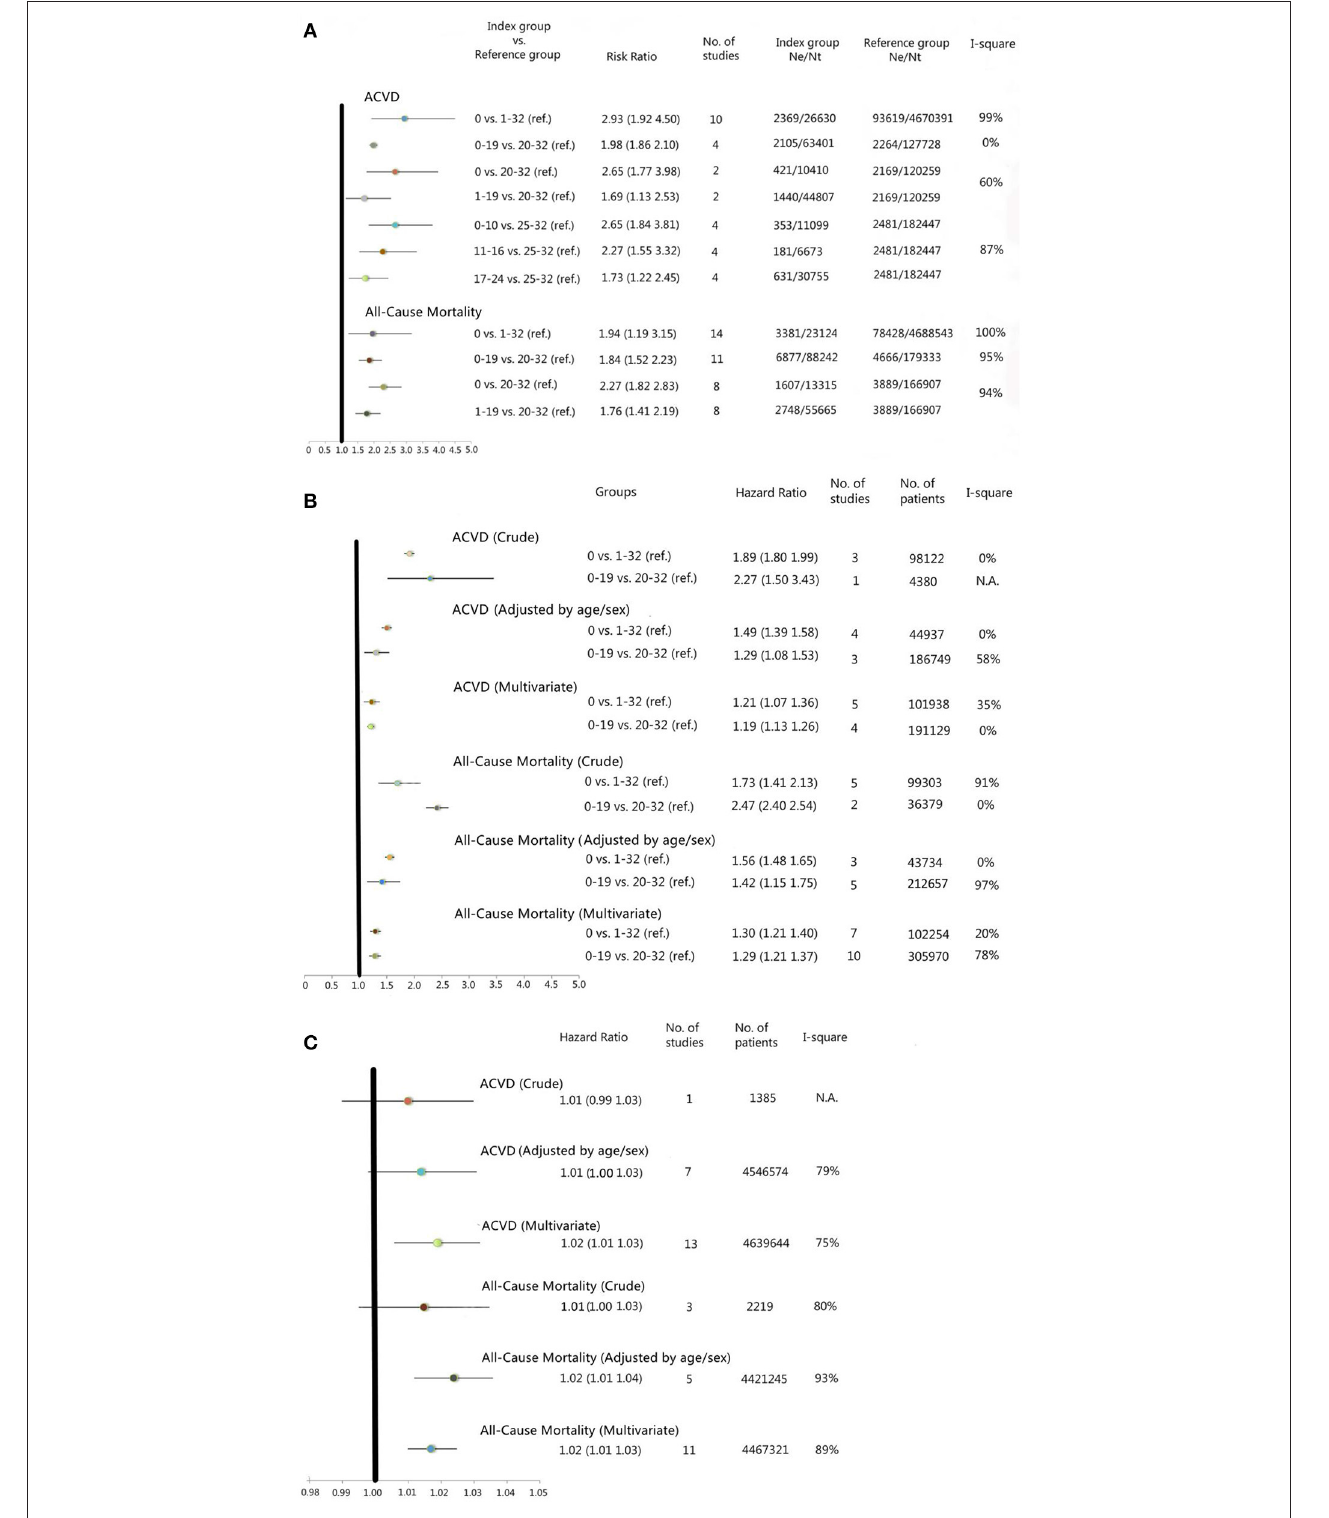
FIGURE 2 | (A) Forest plots for meta-analysis of cumulative incidence for categorical data of the number of teeth, ACVD, and all-cause mortality. (B) Forest plots for meta-analysis of incidence density for categorical data of the number of teeth, atherosclerotic cardiovascular disease (ACVD) and all-cause mortality. (C) Forest plots for meta-analysis of incidence density for continuous data of the number of teeth, ACVD, and all-cause mortality. ACVD, Atherosclerotic Cardiovascular Disease; vs., versus; ref., reference group; Ne, number of events; Nt, number of total included study participants; N.A., Not Applicable. The Hazard Ratio (HR) in the Forest Plot which was based only on one study, was obtained directly from the included